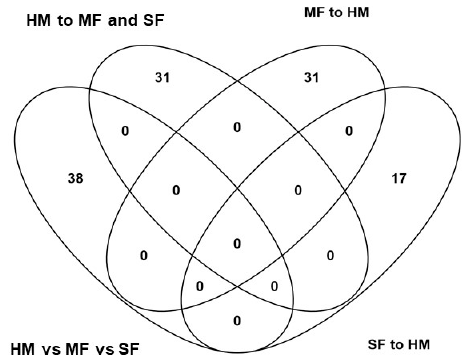
Figure 2. Venn diagram representing the number of metabolites statistically different between the three feeding groups, between formula diet groups [cow’s milk-based infant formula (MF); soy protein-based infant formula (SF)] relative to human milk (HM).